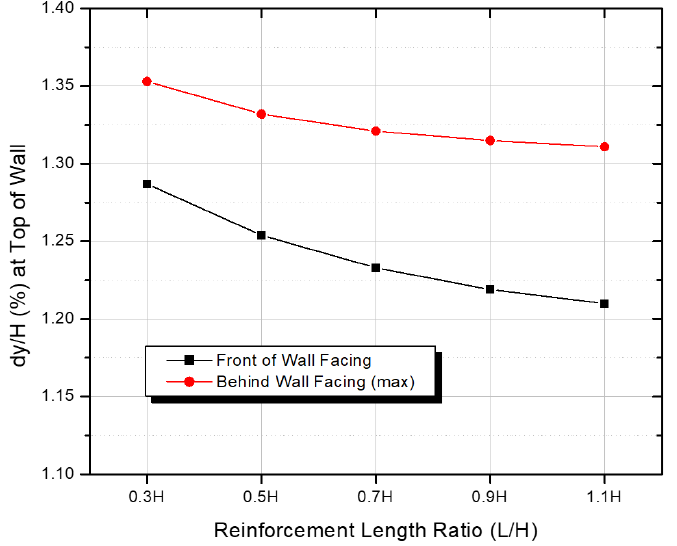
Figure 6. Vertical Displacement Ratio at the Top of Wall.